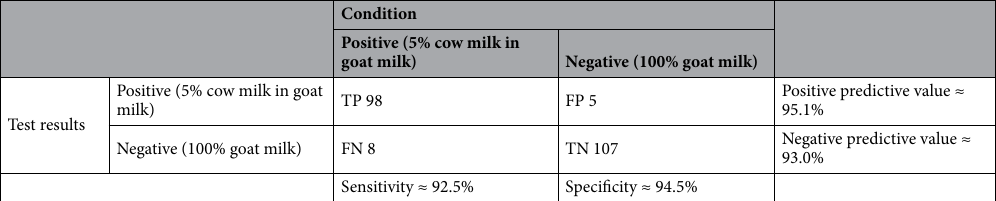
Table 1. Confusion matrix for the detection of 5% cow milk in goat milk using an LDA prediction model based on liquid AP-MALDI MS profiles. The ‘Condition’ columns indicate the real nature of the samples analyzed. The rows ‘Test results’ indicate the results obtained by the classification model. Positives are defined as milk samples with 5% cow milk. Negatives are defined as milk samples without cow milk. TP true positives, FP false positives, FN false negatives, TN true negatives.